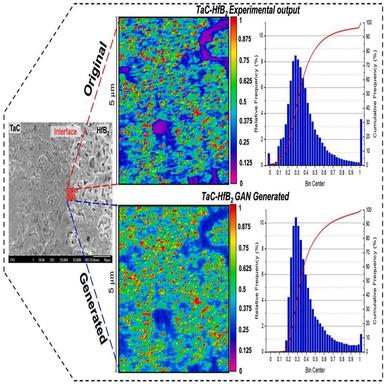
TaC - HfB2 joined ceramic normalized elastic modulus mapping graphical representation and comparison of frequency and cumulative distribution of original recording (Top) and GANs Re-generated datasets (Bottom).